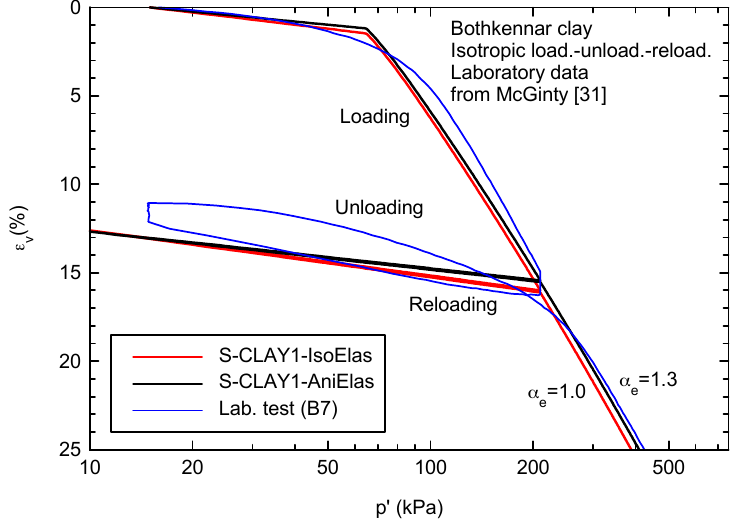
Figure 4. Stress–strain behavior during isotropic loading.